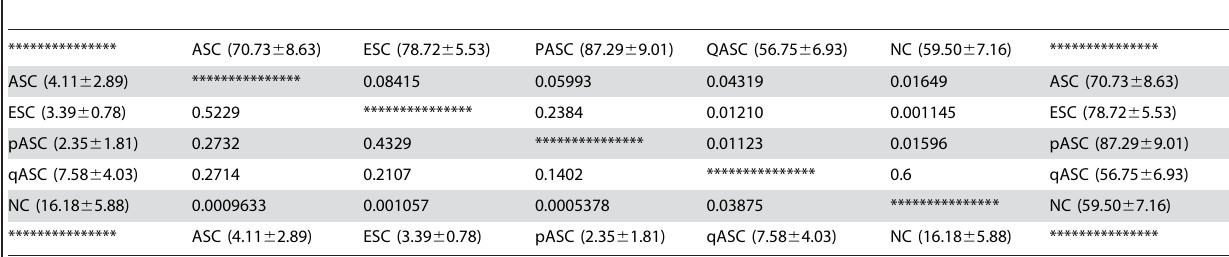
Table 5. The distribution of promoter usage in the SC types and the negative controls (NCs); the upper right section of the table considers the CpG-rich SPs and the lower left section considers the CpG-poor SPs.